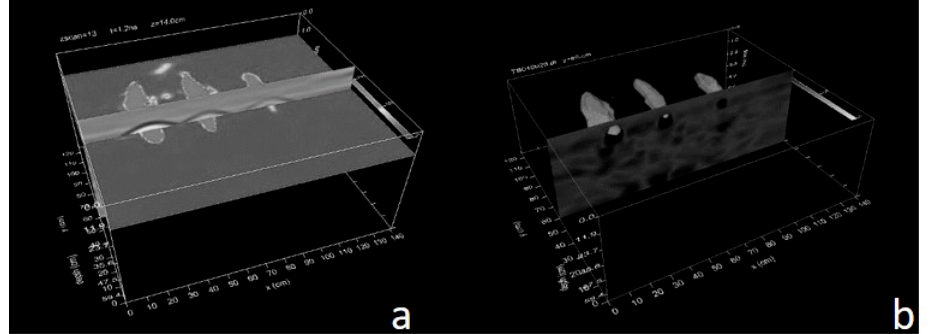
Figure 5. Illustration of: ( a ) time slice and associated filtered radargram; ( b ) isosurfaces derived utilizing Hilbert processed radargram data.